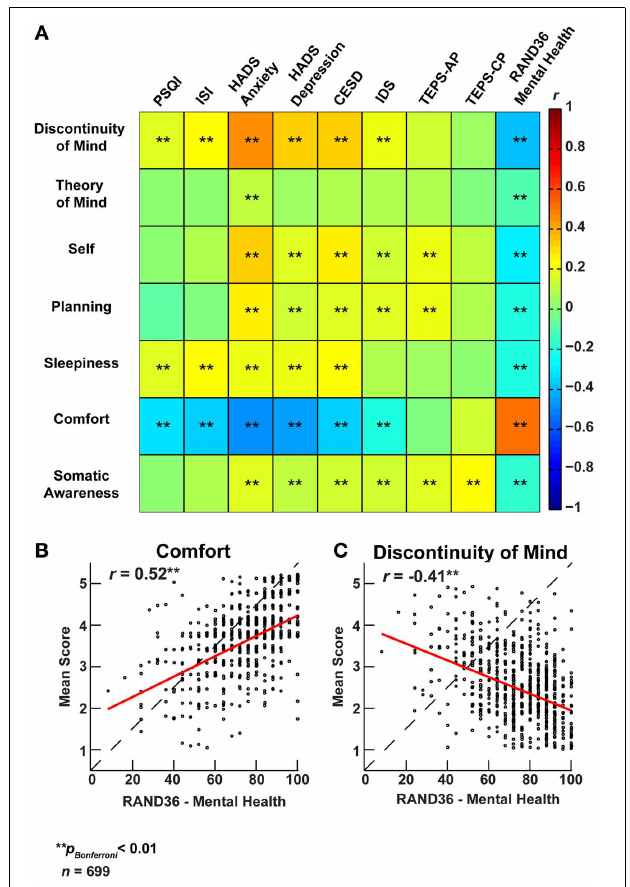
FIGURE 6 | Factors of resting-state cognition strongly correlate with classical measures of general mental well-being. (A) Correlation heat map between the seven ARSQ-derived factors of resting-state cognition and nine established psychometric scales of mental well-being (Pearson correlation coefficients). Note the strong and opposite correlations between the factors Discontinuity of Mind and Comfort and the classical scales. (B) The correlation pattern of Comfort and (C) Discontinuity of Mind reverses for the RAND36 subscale of mental well-being, where high scores should be interpreted as a good mental health. Abbreviations: PSQI, Pittsburgh Sleep Quality Index (Buysse et al., 1989); ISI, Insomnia Severity Index (Bastien et al., 2001); HADS, Hospital Anxiety and Depression Scale (Spinhoven et al., 1997); CESD, Center for Epidemiological Studies Depression Scale (Radloff, 1977); IDS, Inventory of Depressive Symptomatology (Rush et al., 1986); TEPS, Temporal Experience of Pleasure Scale-Anticipatory (AP)/Consummatory Pleasure (CP) (Gard et al., 2006); RAND36, Research And Development 36 (Van Der Zee et al., 1996).